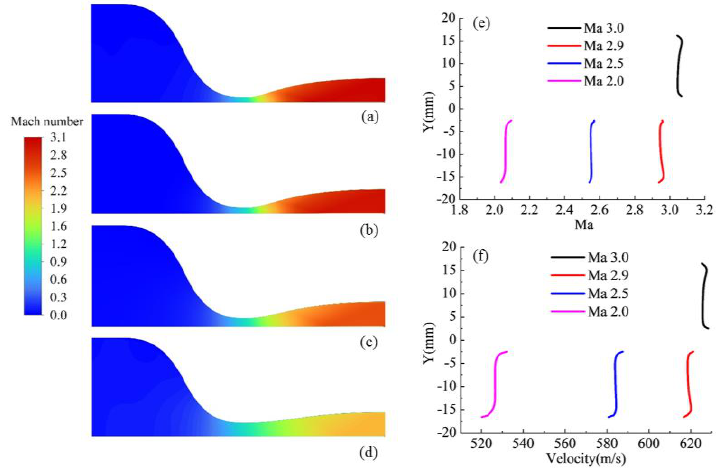
Figure 2. Mach number contours of the nozzles and the Mach number and velocity profiles at the nozzle exits: ( a ) Ma 3.0 contour, ( b ) Ma 2.9 contour, ( c ) Ma 2.5 contour, ( d ) Ma 2.0 contour, ( e ) Mach number profiles at the nozzle exit, ( f ) velocity profiles at the nozzle exit.